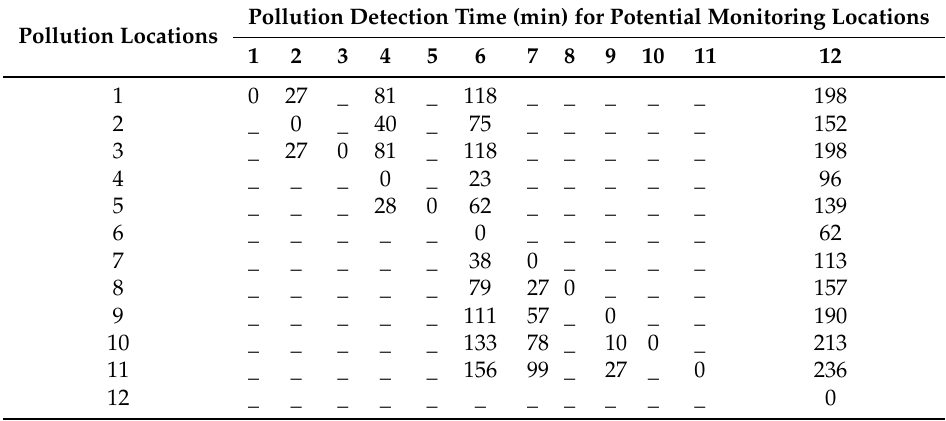
Table 2. Pollution detection time with a detection threshold of 0.01 mg/L.